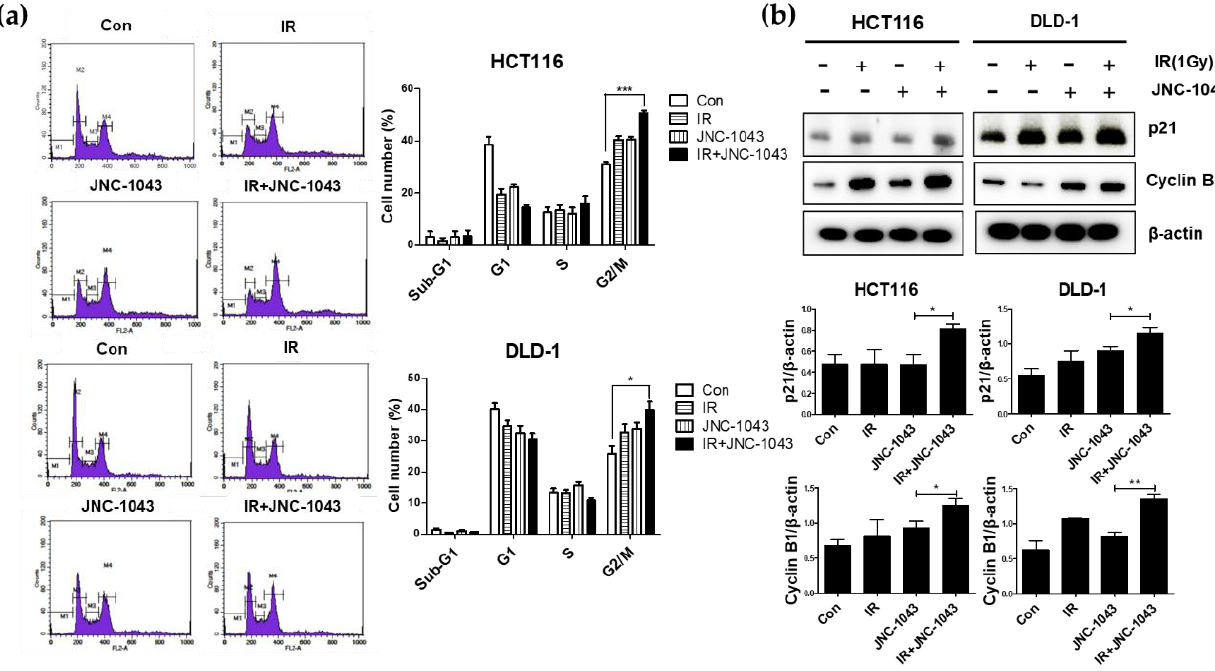
Figure 5. Co-treatment with JNC-1043 and IR promotes G2/M phase arrest in the cell cycle. ( a ) Cell cycle analyses. HCT116 and DLD-1 cells (8 × 10 5 ) were treated with or without 110 or 150 nM JNC-1043, respectively, exposed to 1 Gy IR, and incubated for 2 or 4 h, respectively, prior to harvest. Cell cycle parameters of JNC-1043 and IR co-treated HCT116 and DLD-1 cells were analyzed with a FACSort flow cytometer. ‘Con’, DMSO-treated mock control; ‘IR’, treatment with 1 Gy IR only; ‘JNC-1043 (cid:48) , treatment with 110 or 150 nM JNC-1043 only; ‘IR+JNC-1043 (cid:48) , combination of 1 Gy IR